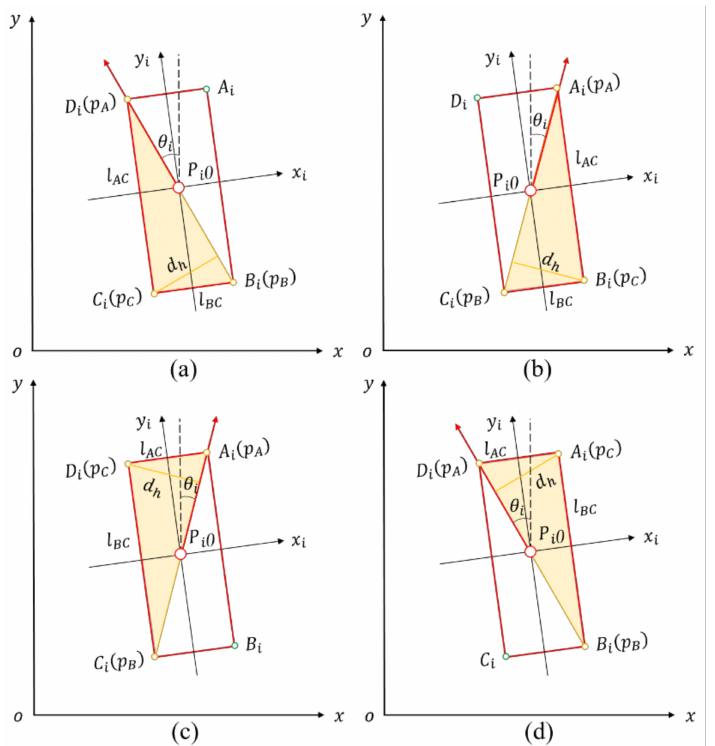
Figure 11. Illustration of the LD algorithm. ( a ) and ( d ) show the left diagonal, and ( b ) and ( c ) show the right diagonal. ( a ) and ( c ) show the farthest points on the left side of the diagonal, and ( b ) and ( d ) show the farthest points on the right side of the